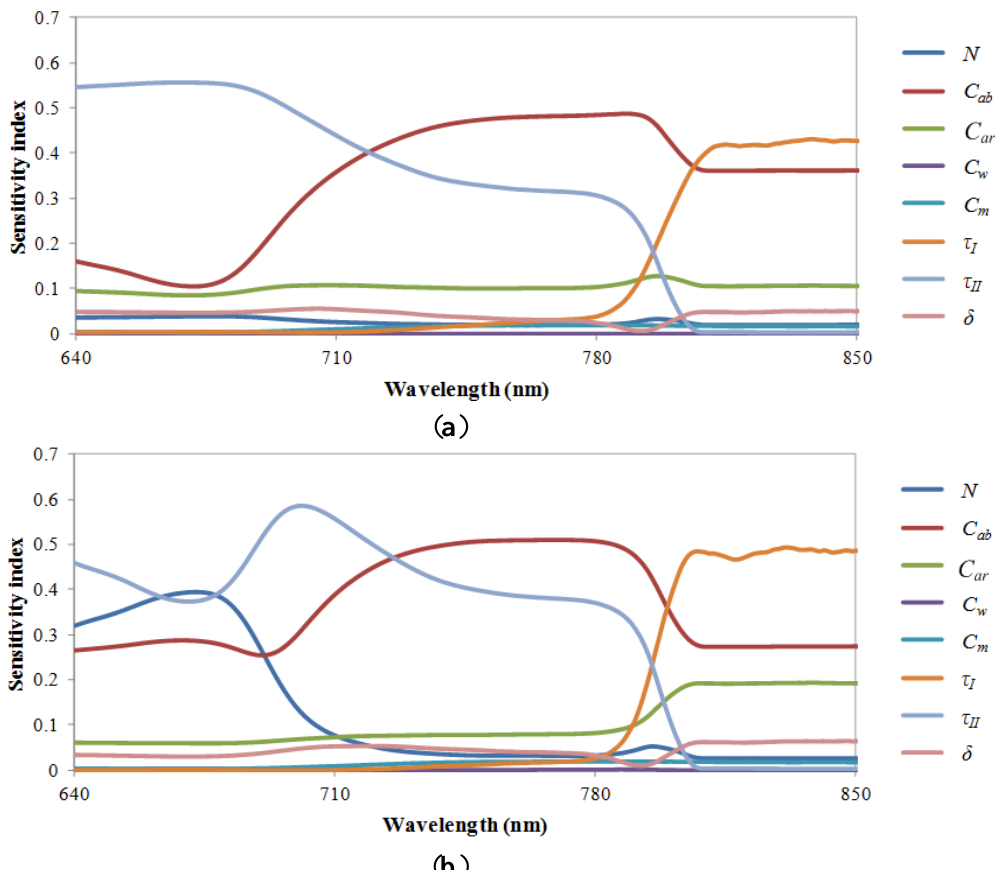
Figure 6. The sensitivity analysis results of the FluorMODleaf model. ( a ) The first order sensitivity indices of the input parameters to the backward fluorescence; ( b ) The first order sensitivity indices of the input parameters to the forward